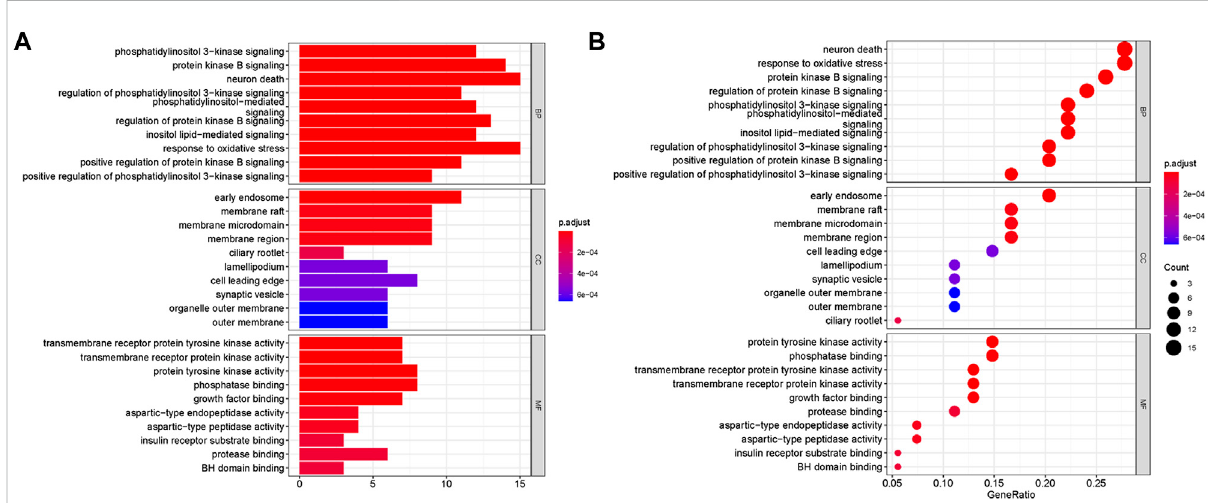
FIGURE 3 Go enrichment analyses of targets represented in bar chart (A) and bubble diagram (B) . The bubble size represents the number of genes enriched passage; the larger the bubble, the more enriched the genes. Bubble colors represent signi fi cant enrichment; the redder the color, the higher the degree of enrichment.